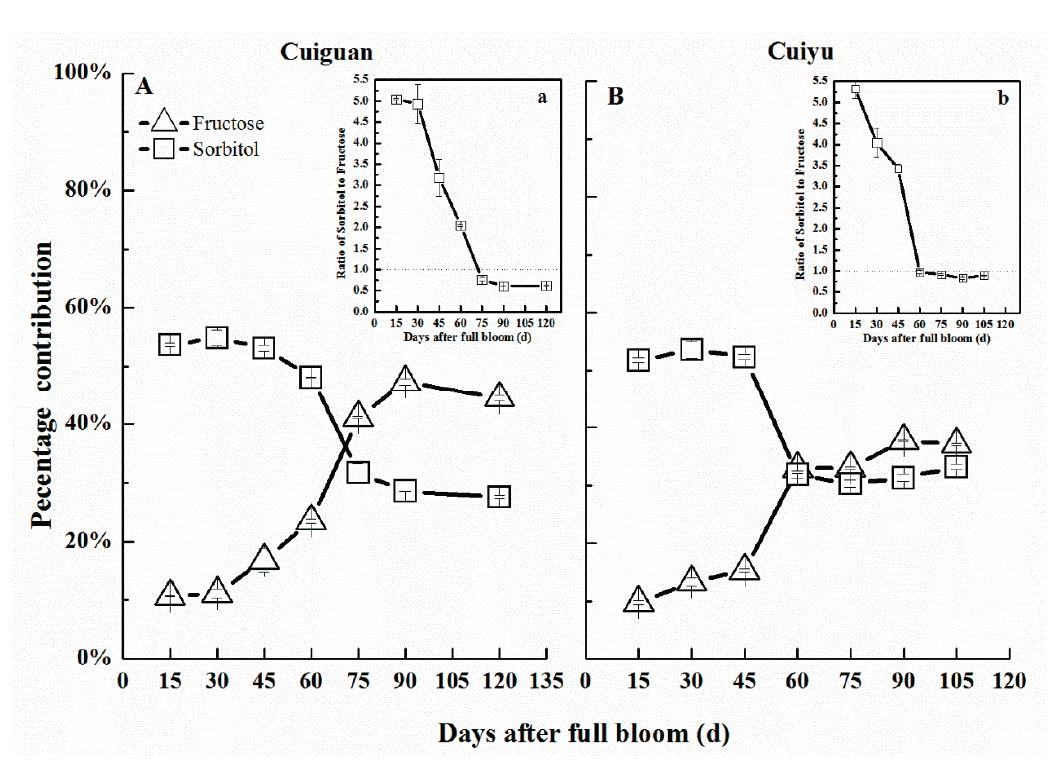
Figure 6. Percentage sorbitol ( □ ) and fructose ( ∆ ) content in total sugars ( A , B ) and the ratio of sorbitol to fructose ( a , b ) during fruit development of two cultivars, “Cuiguan” ( A , a ) and “Cuiyu” ( B , b ). Error bars indicated standard error (SE) from three biological